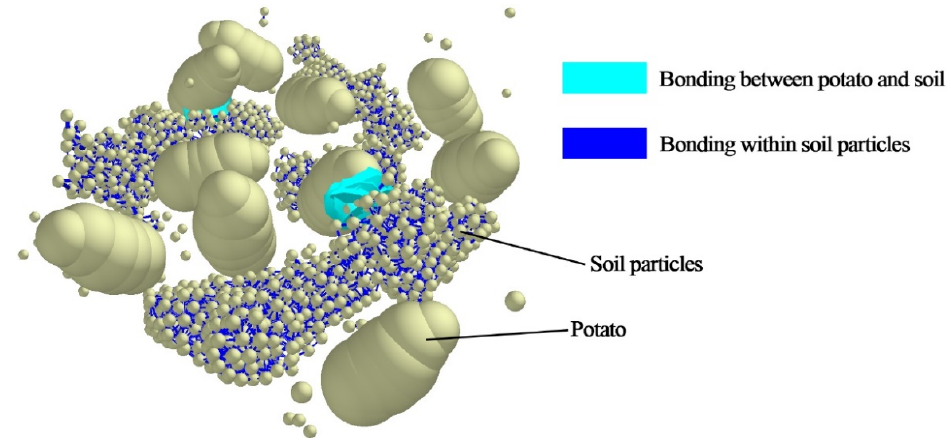
Figure 12. Potato–soil mixtures and their bonding.